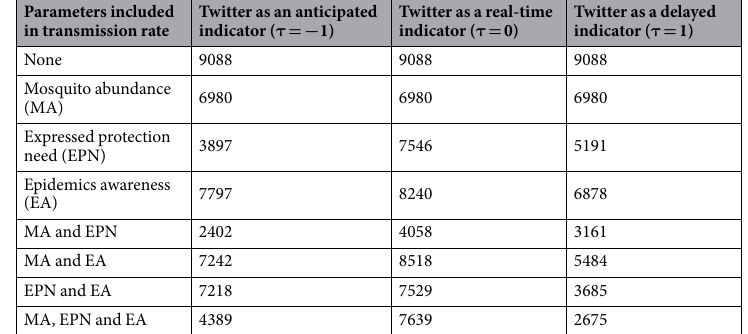
Table 1. Results of model estimation. We show here the squared root of the Mean-Squared Error instead of AIC in order to show the difference between the observed and predicted number of cases. The best model includes the variation in mosquito abundance and the expressed need for protection represented by the proportion of tweets talking about protection against the mosquito in the set of all tweets and retweets that included the word Chikungunya (only Twitter accounts declared in Martinique have been considered). The lag period ( τ ) is expressed in month. AIC values are included in Supplementary Materials.